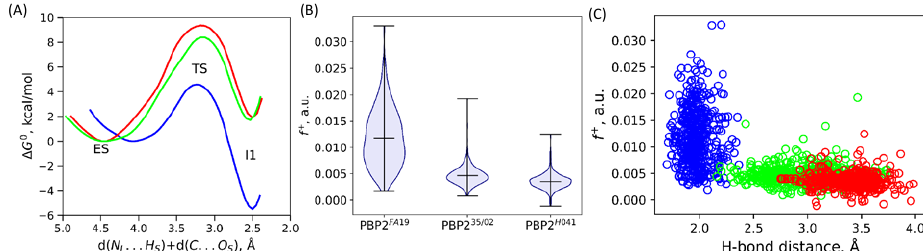
Figure 2. ( A ) Gibbs energy profiles of the first reaction step; a nucleophilic attack of PBP2 acylation by ceftriaxone. ( B ) Violin plots for the distributions of Fukui electrophilicity indices of the carbonyl carbon atom of the substrate, f + , in ES state. ( C ) Scatter plots of distances of a longer hydrogen bond in the oxyanion hole at each QM/MM MD frame versus Fukui index in the corresponding frame. Color code for panels A,C: PBP2 FA19 –blue, PBP2 35/02 –green and PBP2 H041 –red.